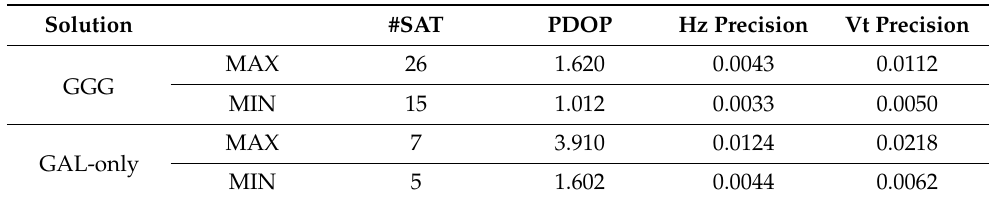
Table 3. Range of #SAT, PDOP, Hz Precision, and Vt Precision estimation values for solutions based on ‘GGG’ and ‘GAL-only’